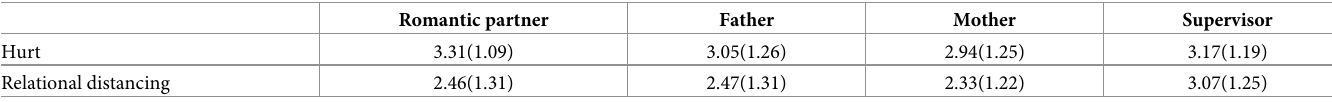
Table 4. Mean (SD) ratings of hurt and relational distancing by source.